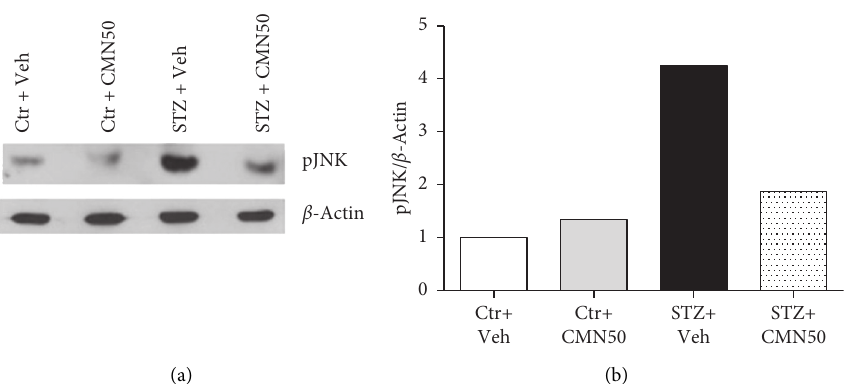
Figure 3: Western blot analysis of pJNK protein expression in the dorsal root ganglion (DRG). Total protein extraction from DRG was used for the western blot analysis. pJNK expression was increased in streptozotocin- (STZ-) induced diabetic neuropathic pain rats (STZ+Veh, n � 6), which was subsequently normalized by treatment with 50mg/kg/day of curcumin (CMN) for 4 consecutive weeks (STZ+CMN50, n � 6). ß -Actin is a loading